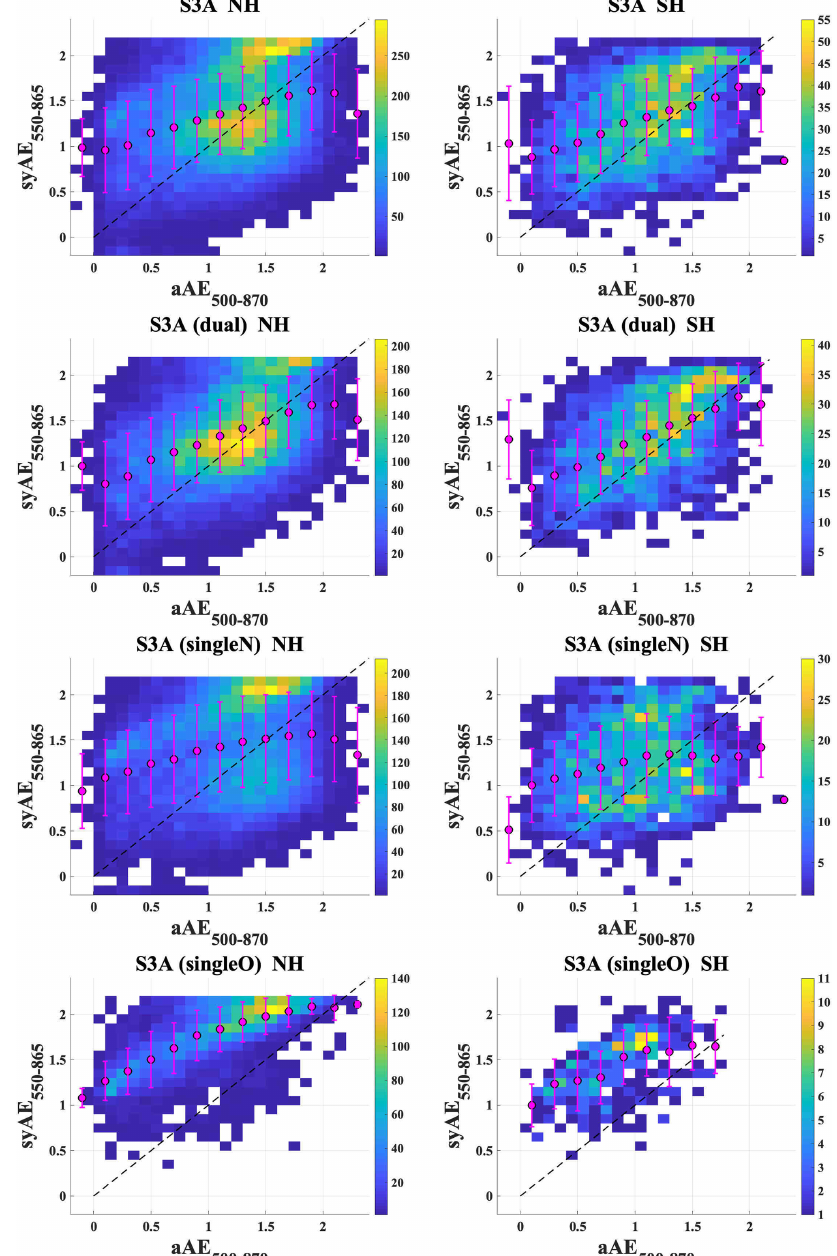
Figure 23. Scatter plots between syAE 550–865 and aAE 500–870 for S3A for the NH and SH (panels left and right, respectively) for different groups of products (top-down: all, dual, singleN, and